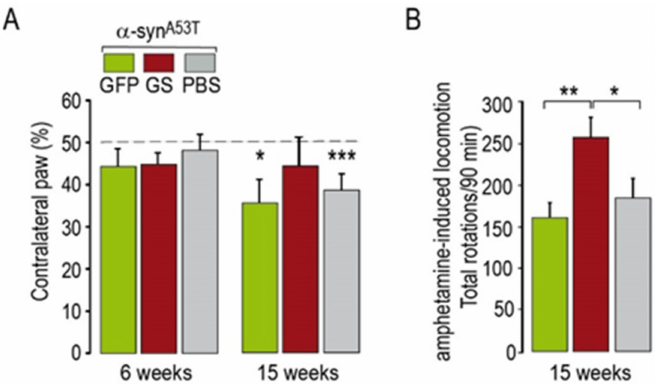
Figure 4. Motor tests in rats co-injected with AAV- α -syn A53T and AAV-GFP or AAV- α -syn A53T and AAV- ∆ LRRK2 G2019S ( ∆ LRRK2 GS ). ( A ) Rats were tested using the cylinder test at 6 and 15 weeks PI to detect asymmetry in forepaw use. ( B ) Rats were injected with methamphetamine (2.5 mg/kg) to induce hyper-locomotion. Results are expressed as the means ± SEM. N = 8–12 animals/group. ANOVA and PLSD post hoc test. * p < 0.05, ** p < 0.01, *** p < 0.001.